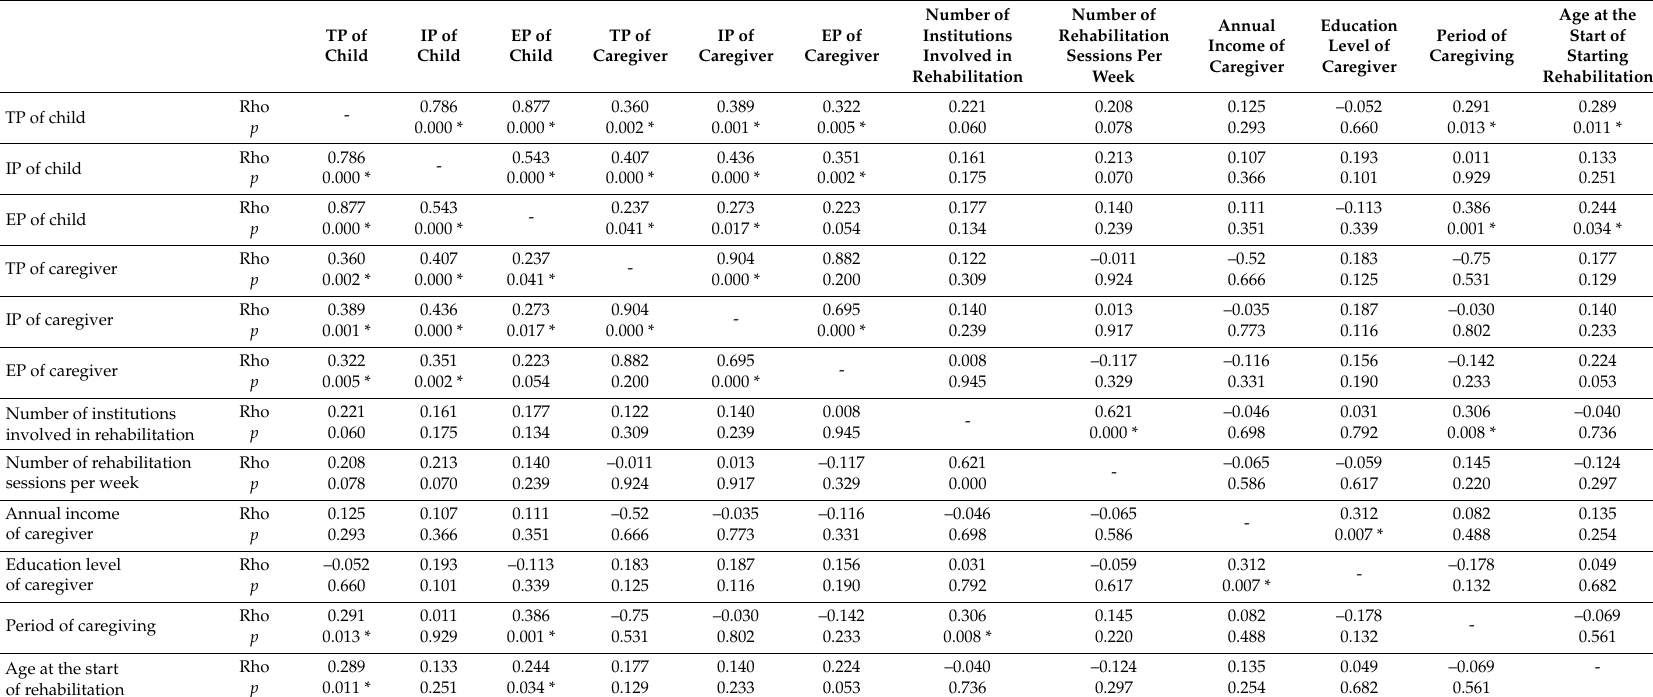
Table 3. Correlations between all measured